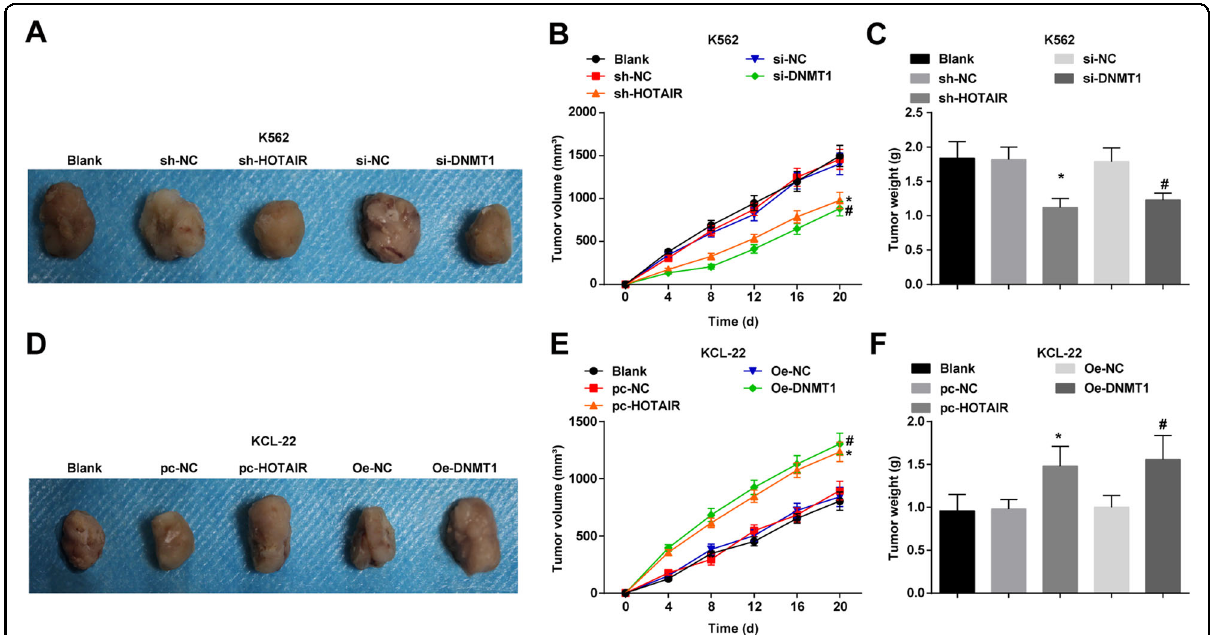
Fig. 6 Low expression of HOTAIR or DNMT1 reduces the volume and weight of tumor in mice injected with CML cells. A K562 cell xenografts in each group. B Tumor volume change of K562 cell xenografts in each group. C The tumor weight of K562 cell xenografts in each group. D KCL-22 cell xenografts in each group. E Tumor volume change of KCL-22 cell xenografts in each group. F, The tumor weight of KCL-22 cell xenografts in each group. In K562 cells, * P < 0.05 vs. the sh-NC group, # P < 0.05 vs. the si-NC group. In KCL-22 cells, * P < 0.05 vs. the pc-NC group, # P < 0.05 vs. the OE-NC group. n = 3. Measurement data were depicted as mean ± standard deviation. Comparisons among multiple groups were assessed by one-way ANOVA followed by Tukey ’ s multiple comparisons